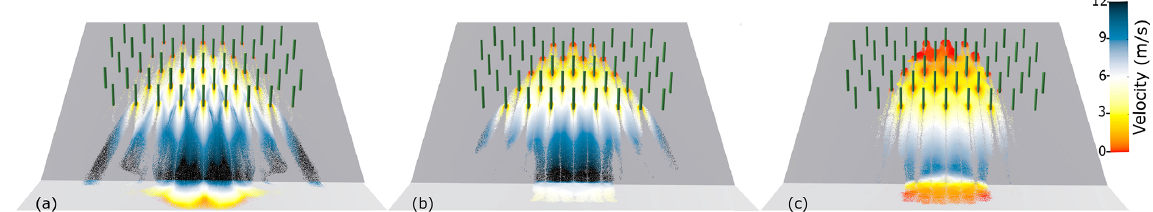
Figure 3. Flow profile for three different flow regimes: (a) Case 1, (b) Case 2, and (c) Case 3, for a regular staggered forest at t = 10s, e = 8m, d = 1m, and v 0 = 10ms − 1 .